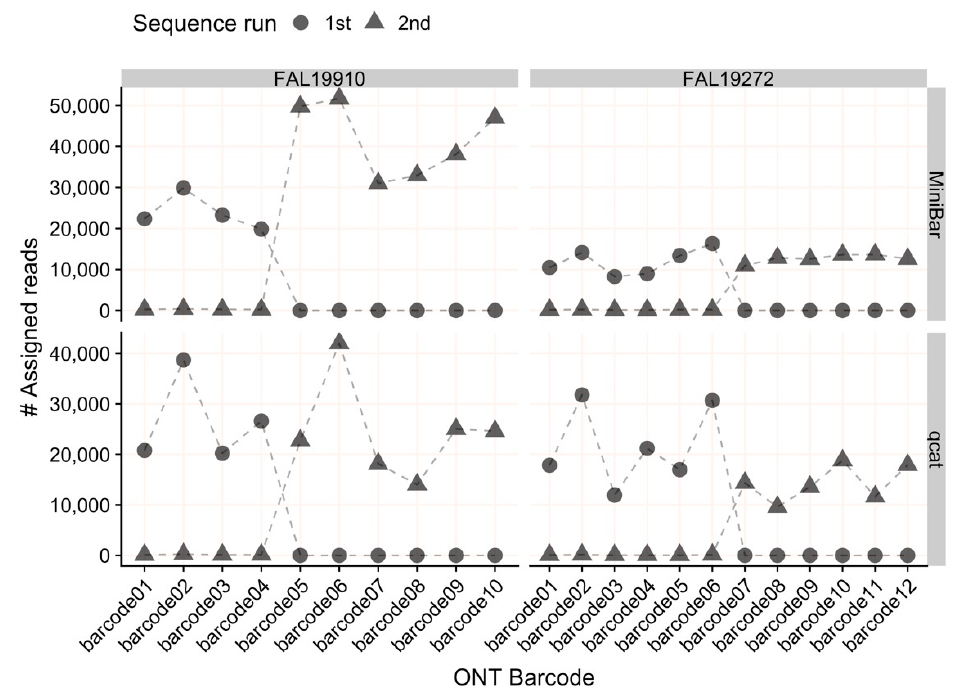
Figure 2. The number of reads assigned to each Oxford Nanopore Technologies (ONT) index (01–12) per flow cell by MiniBar and by qcat. For flow cell FAL19910, the 1st sequencing run used indexes 01–04 and the 2nd run used indexes 05–10. For flow cell FAL19272, the 1st sequence run used indexes 01–06 and the 2nd run used indexes 07–12.